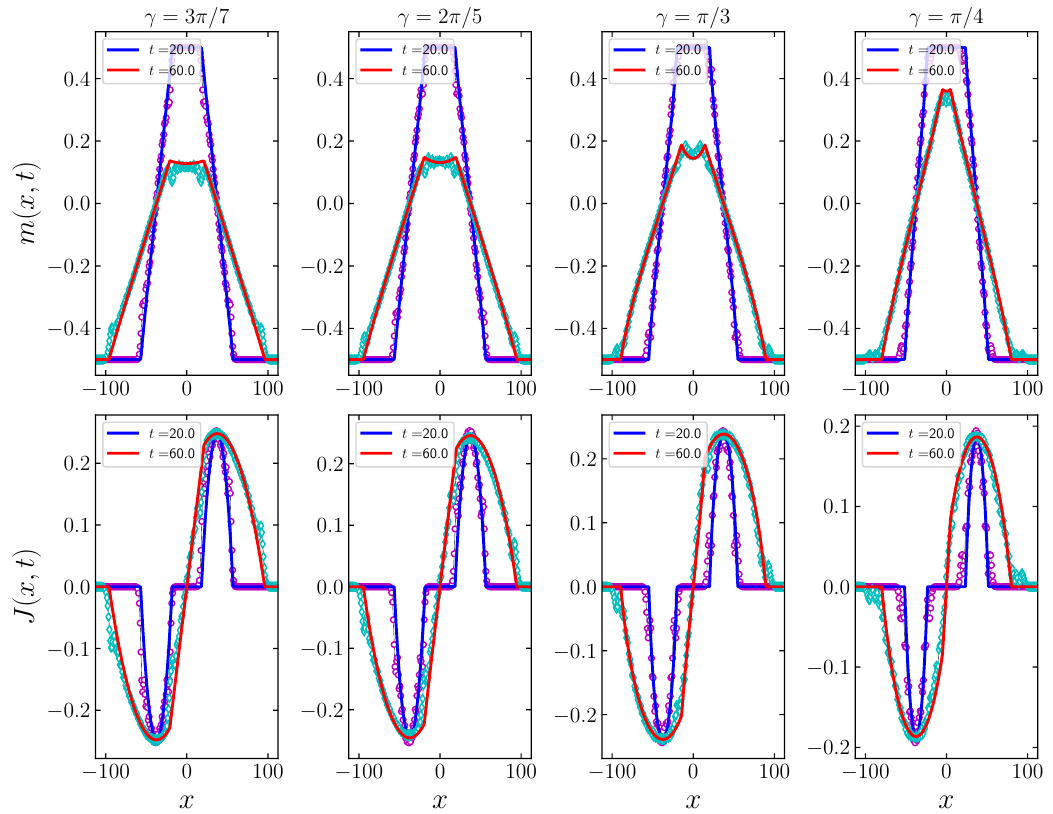
Figure 8: (Top) Magnetization and (bottom) spin current profiles during the double domain wall melting dynamics for several values of the interaction coupling γ (cor- responding to ∆ = 0.223,0.309,0.5,0.707, from the left to the right panels). The different curves show the behavior of the analytic solutions (21)-(22) at different times while the symbols are obtained with tDMRG numerical simulations obtained for a lattice of size L = 225 and (cid:96) = 35. The matching of the profiles with the numerics is seen to be very good although finite-size effects are still